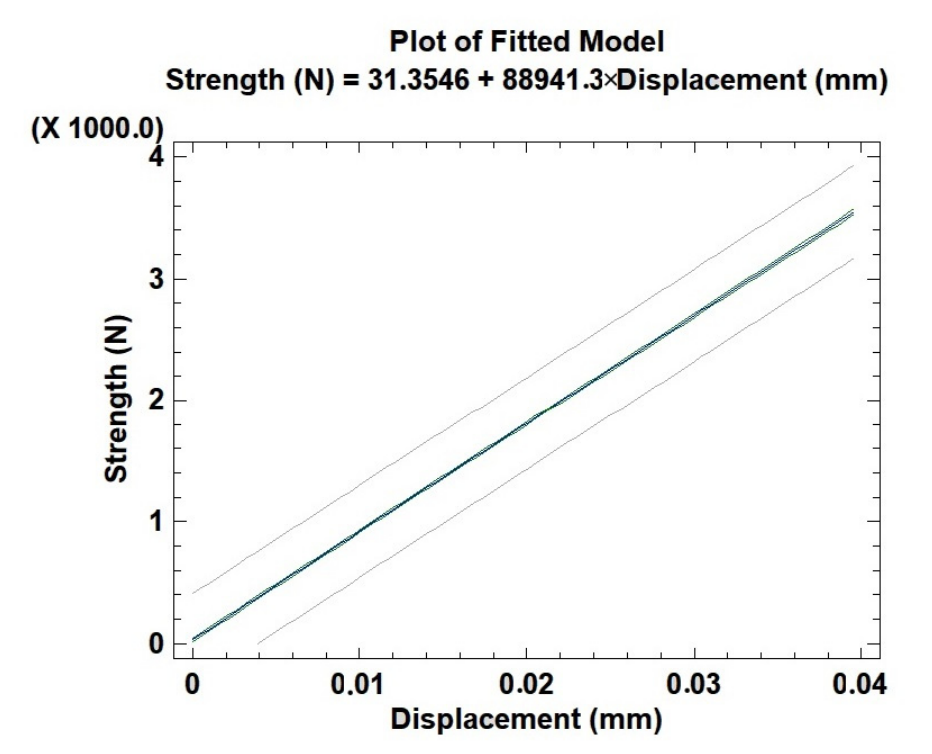
Figure 12. Graph of the adjusted model Test 1. Composite material 60% fly ash (D: 20 mm/E: 70 mm).